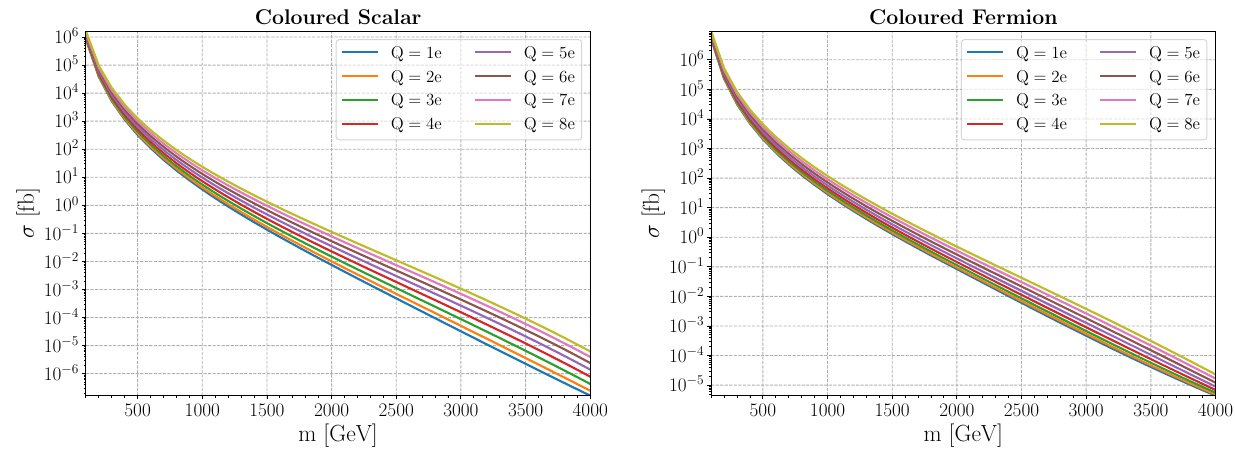
Fig. 4 Leading order production cross sections, pp → ξ + Q ξ − Q , for coloured scalars (left) and fermions (right). The curves with different colours correspond to different electric charges